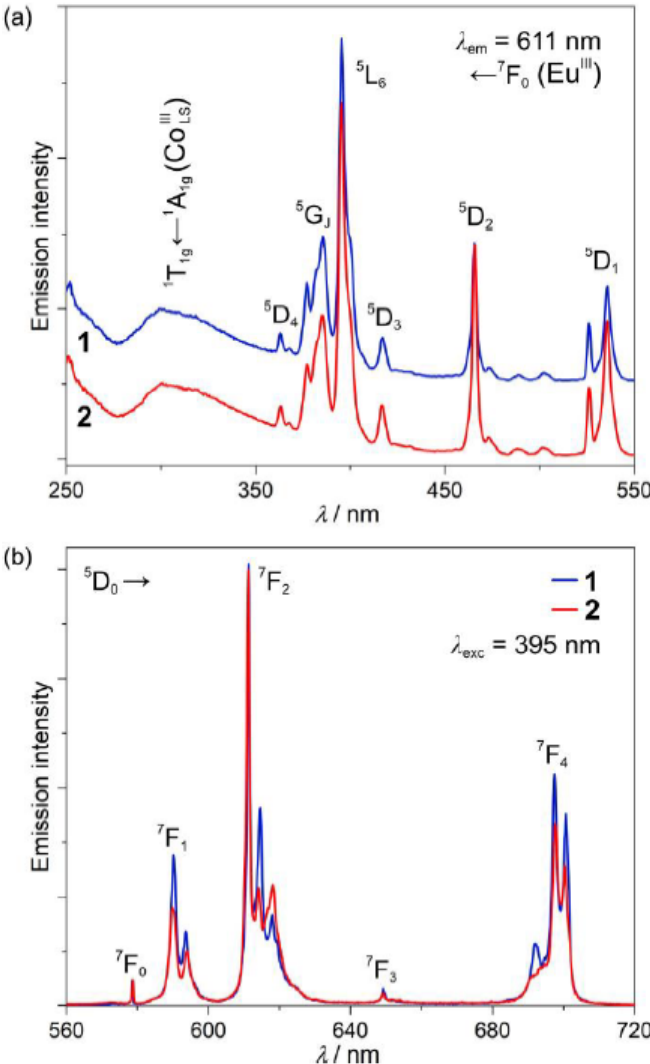
Figure 3. Room-temperature emission properties of 1 and 2 . Excitation spectra monitored at λ em = 611 nm ( a ), and emission spectra measured under irradiation with λ exc = 395 nm ( b ). The main electronic transitions are assigned in the